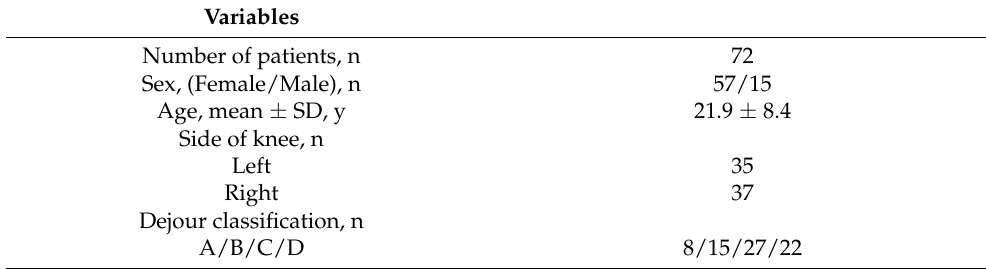
Table 2. ICC values of the anatomic parameters for inter-observer reliability, showing mean ±